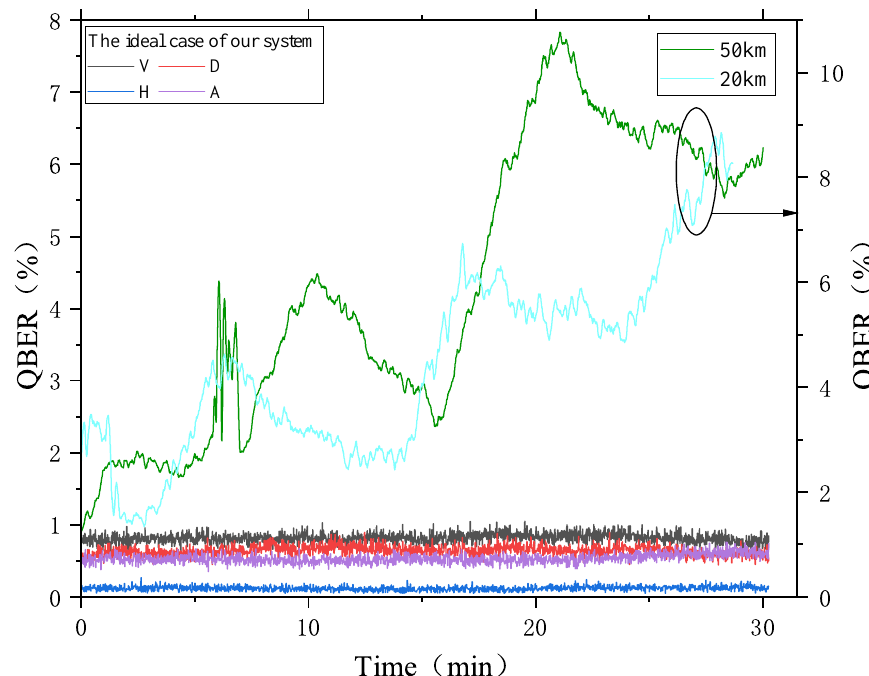
Figure 2. Measured QBERs of four polarization states of | H (cid:105) , | V (cid:105) , | D (cid:105) , | A (cid:105) , and 20 km and 50 km commercial optical fiber for 30 min, demonstrating